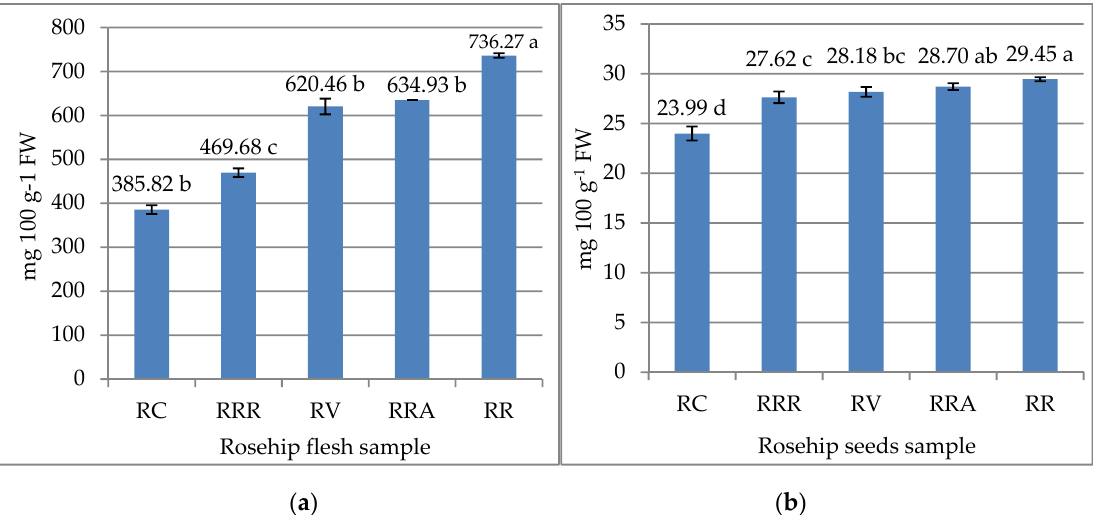
Figure 3. Ascorbic acid content (mg 100 g − 1 fresh weight (FW)) of different organic rosehip flesh ( a ) and seed ( b ) samples species. Different small letters represent significant differences between flesh samples and seed samples species, respectively ( p < 0.05). RRA: Rosa rugosa ‘Alba’; RC: Rosa canina ; RR: Rosa rugosa ; RRR: Rosa rugosa ‘Rubra’; RV: Rosa villosa .